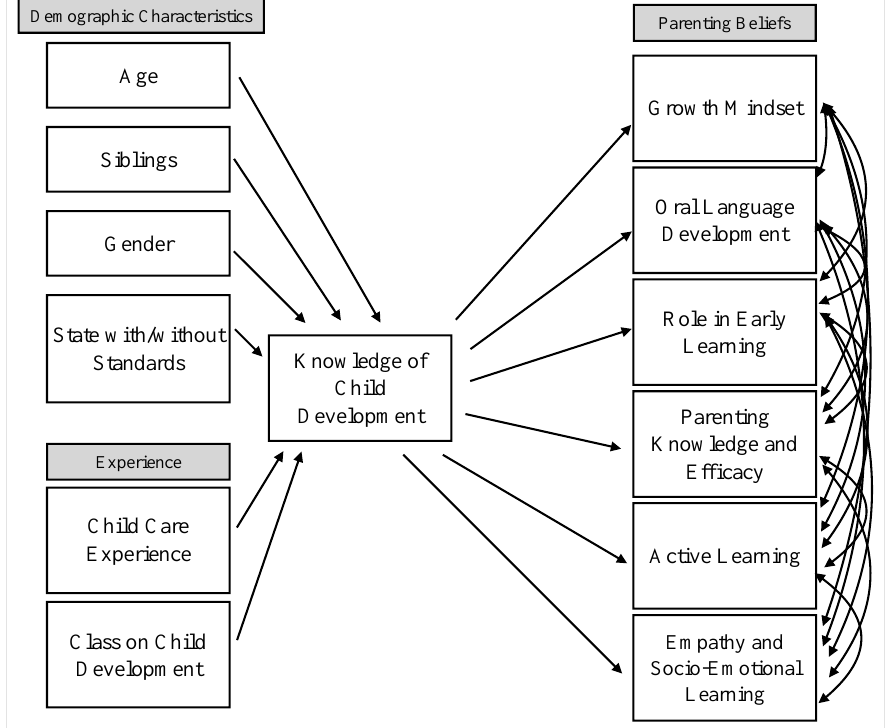
Figure 1. Proposed conceptual model of the relationships between demographic characteristics, experience, knowledge of child development, and parenting beliefs.